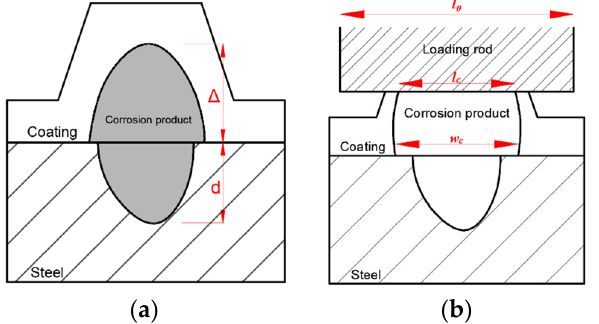
Figure 3. Schematic illustration of pitted corrosion effect on the deformation of the epoxy coating ( a ) deformation under only corrosion, and ( b ) deformation under loading and corrosion.